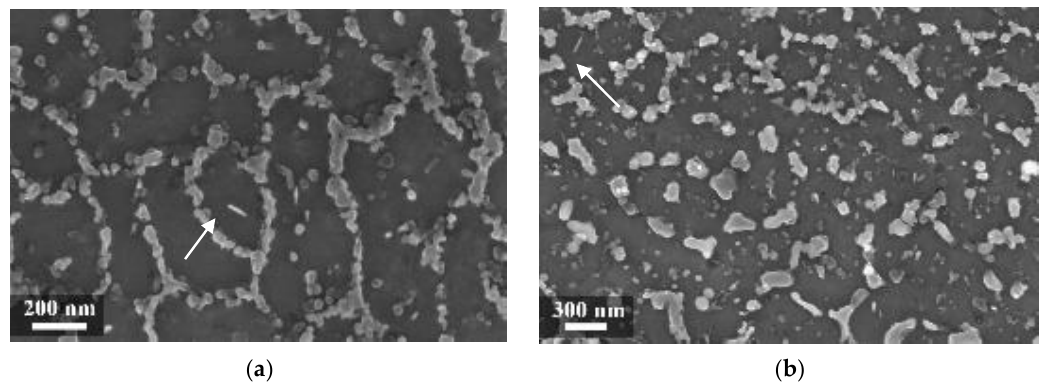
Figure 9. Microstructure of the AlSi10Mg specimen after stress relieved at 300 °C ( a ) MP and ( b ) HAZ (T platform 35 °C).